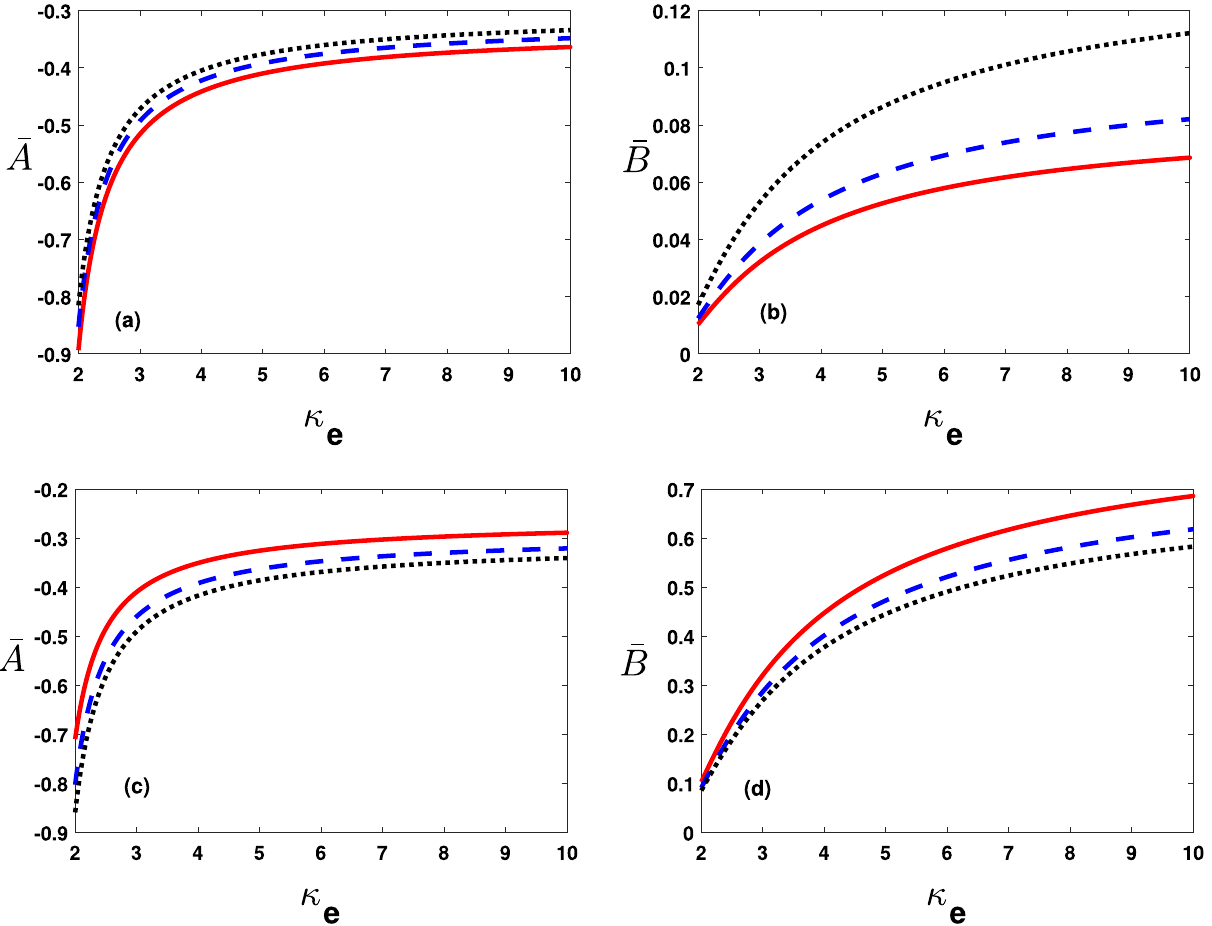
10 − 8 cm 3 s − 1 ) 10 11 cm ( statVs ) − 1 ) and B (= B / B 0 with B 0 Figure 3. The coefficients ¯ A (= A / A ( 0 ) with A ( 0 ) ¯ = = 10 3 K (solid varying with κ e from 2 to 10 ( a ) by changing hot electrons temperature values for ¯ A as T h = 10 3 K (dashed curve) and 1.3 10 3 K (dotted curve), ( b ) hot electrons temperature values for B curve), 1.1 ¯ × × 10 3 K (dashed curve) and 1.1 10 3 K (dotted curve), ( c ) by changing cold 10 3 K (solid curve), 1.05 as T h × × = 10 3 (solid curve), 1.3 10 3 (dashed curve) and 1.5 10 3 K (dotted electrons temperature values for ¯ A as T c = × × 10 3 K (solid curve), 1.3 10 3 K (dashed curve) and ( d ) by changing cold electrons temperature values ¯ B as T c = × 10 3 K (dotted curve) and 1.5 ×